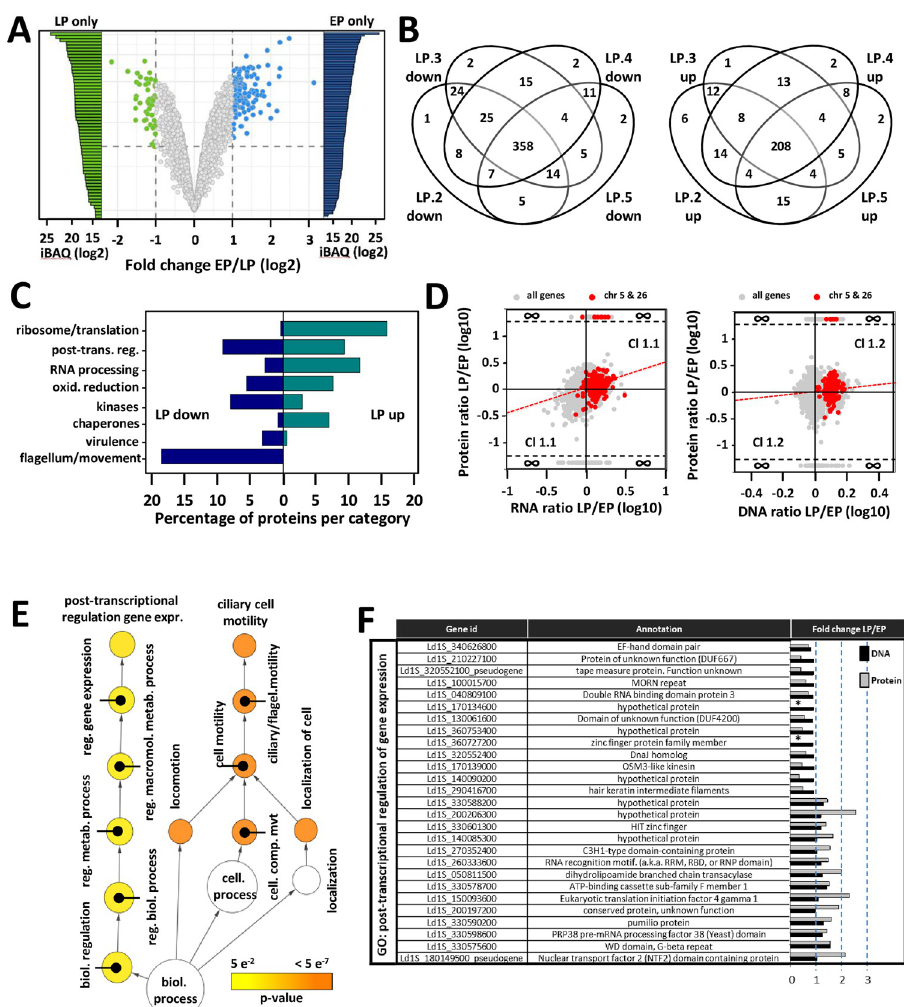
Fig 4. Quantitative analysis of the fitness-adapted proteome. (A) Volcano plot representing changes in protein abundance in EP log (blue dots, mean values of EP.2, EP.3, EP.4 and EP.5 are shown) compared to LP log (green dots, mean values of LP.2, LP.3, LP.4 and LP.5 are shown). Proteins identified by at least two peptides in at least three out of four biological replicates were considered. Colored dots indicate values with FDR < 0.01 and fold changes � 2 (see Sheets b and f in S6 Table). The grey dots indicate non-significant expression changes. The bars indicate unique protein identifications in LP (LP only, green) and EP (EP only, blue) samples, with relative abundance indicated by the iBAQ value. (B) Venn diagram showing the number of proteins quantified and associated to a p-value < 0.01 with increased (left panel) or decreased (right panel) abundance in all four LP log biological replicates (see Sheets c and e in S6 Table). (C) Manual Gene ontology analysis of the proteins shared in all four LP log biological replicates expressed as the percentage of proteins quantified with associated p-value < 0.01 for the indicated gene categories (see Sheets h and I in S6 Table). (D) Double ratio plots comparing the fold changes computed for each gene between LP and EP log parasites for RNA (x-axis) versus protein (y-axis) (left panel) and DNA (x-axis) versus protein (y-axis) (right panel). All proteins with LFQ values were considered to determine the protein ratio LP/EP (see Methods). Grey dots represent all proteins and red dots those encoded on trisomic chromosomes 5 and 26 (see Sheets a and h in S7 Table). Cluster 1.1 and 1.2 (Cl 1.1 and Cl 1.2) includes proteins whose change in abundance shows the same tendency compared to RNA abundance or gene dosage, respectively. The regression line is represented by the dotted red line. The Pearson correlation coefficients and the p-values were estimated for both ratio plots using Sigma Plot software. For protein versus RNA ratio plot: ρ = 0.349 and p-value < 10 − 10 . For protein versus DNA ratio plot: ρ = 0.145 and p- value < 10 − 10 . (E) Graphical representation of the GO term-enrichment analysis for the category ‘biological process’ for the 452 proteins from cluster 1 (common proteins between clusters 1.1 and 1.2), which includes 201 proteins with a GO annotation (cluster 1, see right panel D and Sheet c in S7 Table). The size of the circle is indicative of the number of genes falling in each category and the color ranging from yellow to orange indicates the p-values associated as indicated in the legend. Only proteins quantified in all four biological replicates for each condition and associated